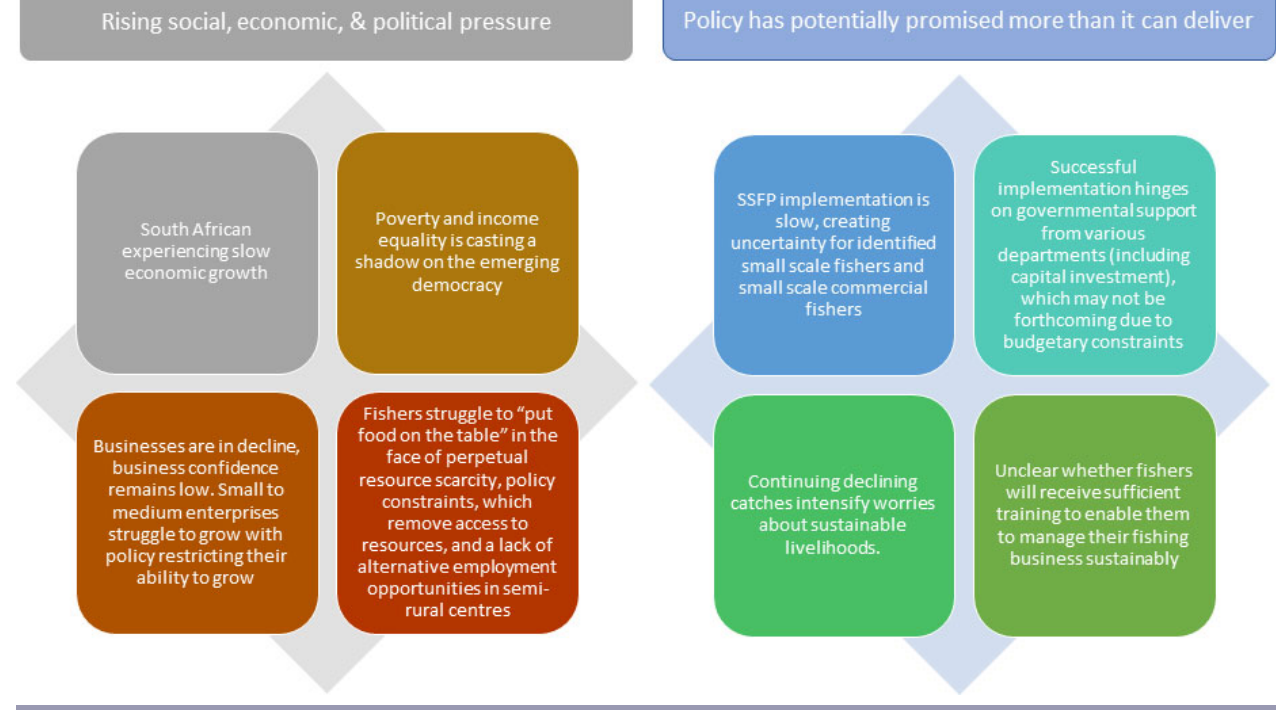
Fig. 6 . Starting point conditions (background) information for all the scenario stories. This background information is based on information of the macro system as it stands today from the Indlumamithi South African Scenarios (http://sascenarios2030.co.za/), the Vumelana land scenarios (https://www.landreformfutures.org/) and previous research into this fishery (Gammage et al. 2017a, b,